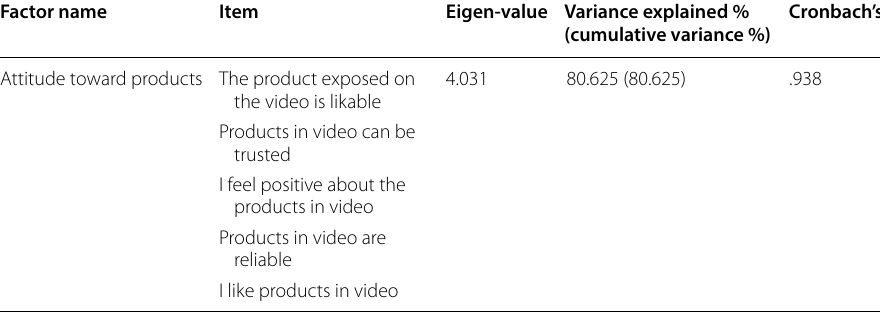
Table 3 The result of principal factor analysis for attitude toward product